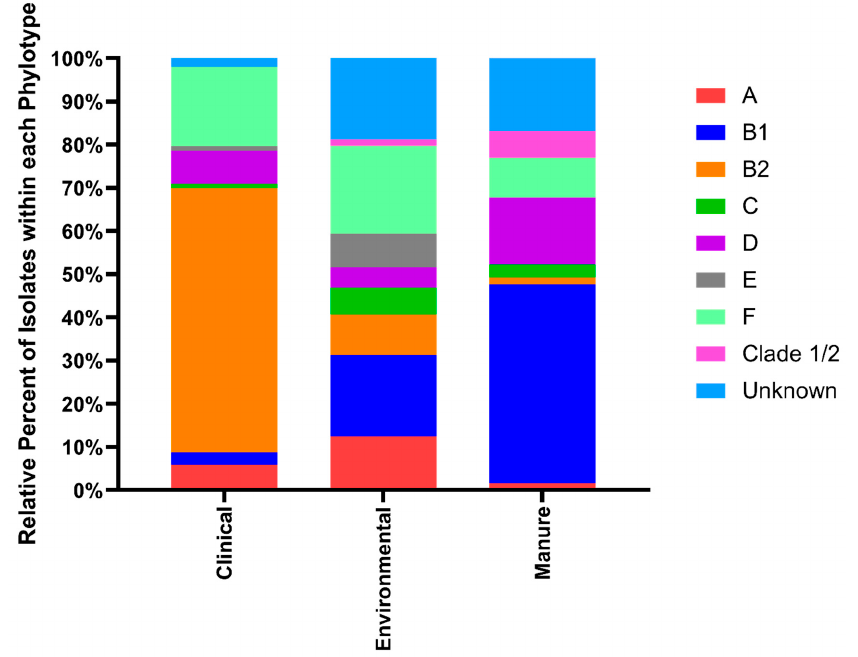
Figure 4. Relative percentage of E. coli isolate phylotype within clinical, environmental, and manure isolation sources.